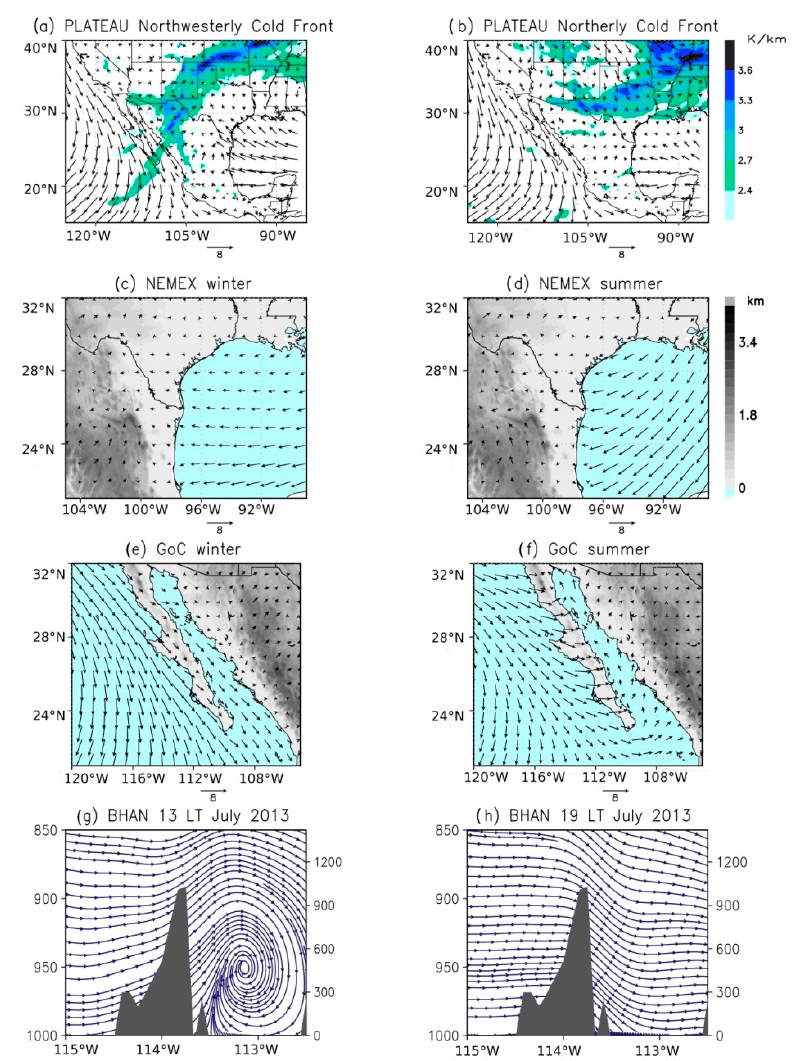
Figure 3. Typical weather systems modulating wind power ramp variability over four different regions in Mexico. Topography, in km (grey shaded). Composite pattern of gradient of equivalent potential temperature ( × 10 − 2 K / km) and ERA5 surface wind as front position indicator (Plateau) for 2014–2015 during ( a ) westerly cold front and ( b ) northerly cold front; NEMEX surface wind climatology from 1979–2018 during ( c ) winter, ( d ) summer; BCP surface wind climatology from 1979–2018 during ( e ) winter, ( f ) summer; mean circulation on the x–z plane calculated with the NAM analysis model at ( g ) 1300 local time (LT) for July 2013, ( h ) 1900 LT for July 2013 at BHAN latitude (28.89 ◦ N).